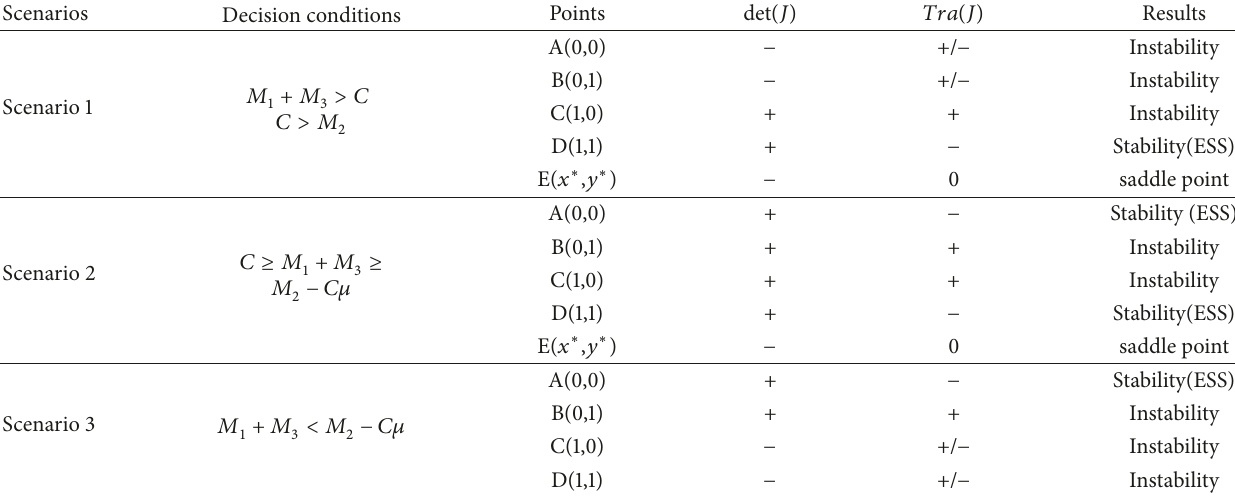
Table 4: The local stability analysis of 3 different